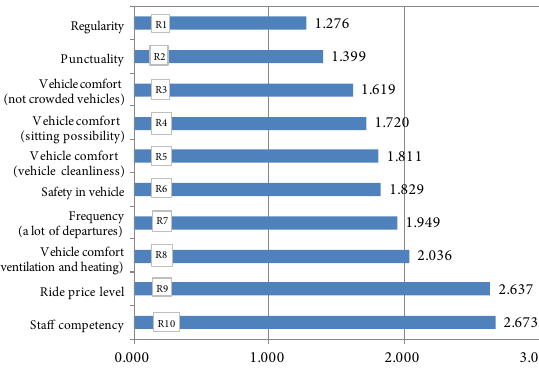
Figure 3. Quality of service sub-features in urban public passenger transport system in Belgrade based on